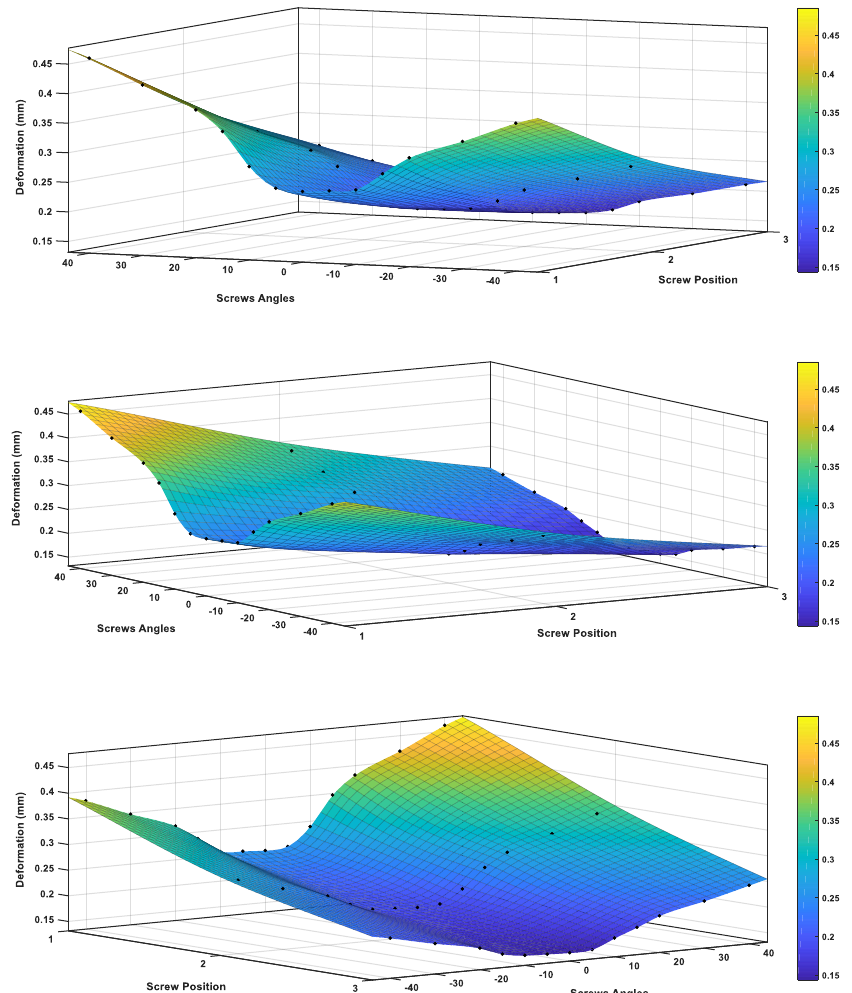
Figure A19. VANS displacement vs. screw angles and screw position.